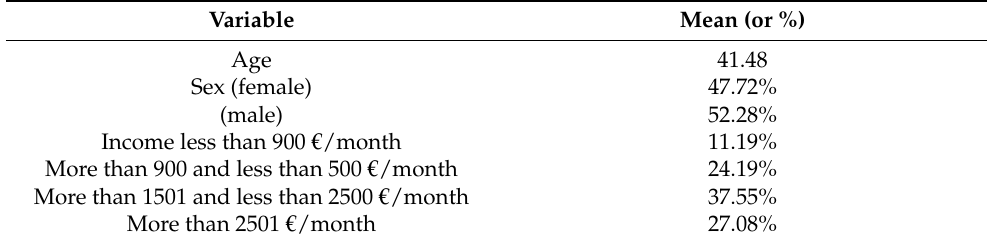
Table 1. Main descriptive statistics of the sample.